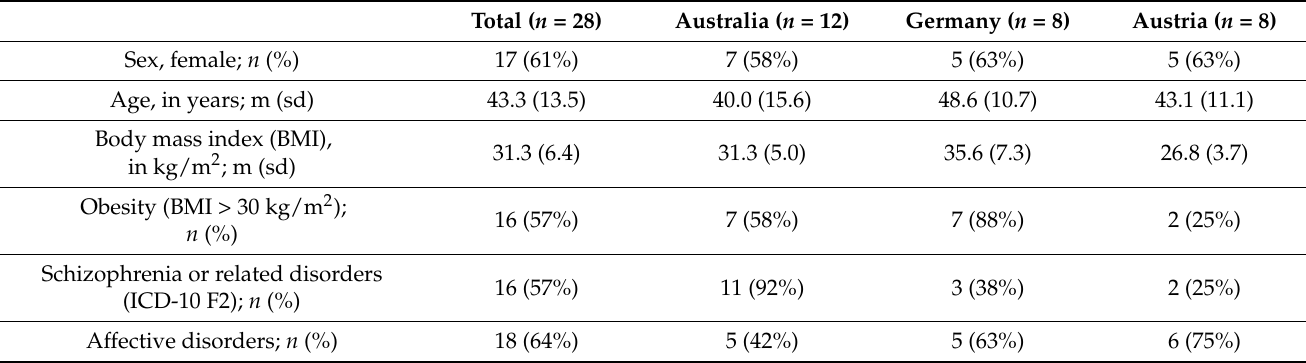
Table 1. Description of study population.